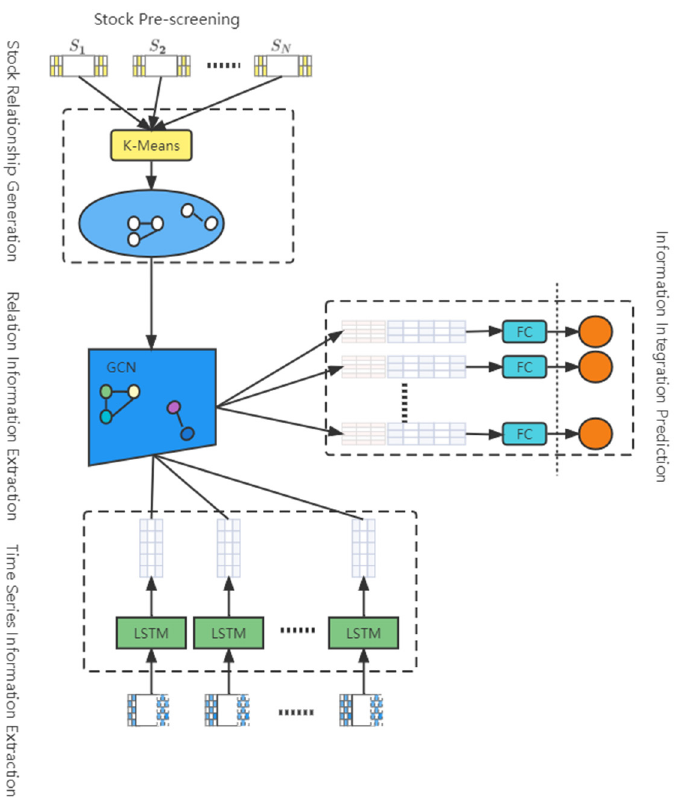
Figure 2. Time series relational model.